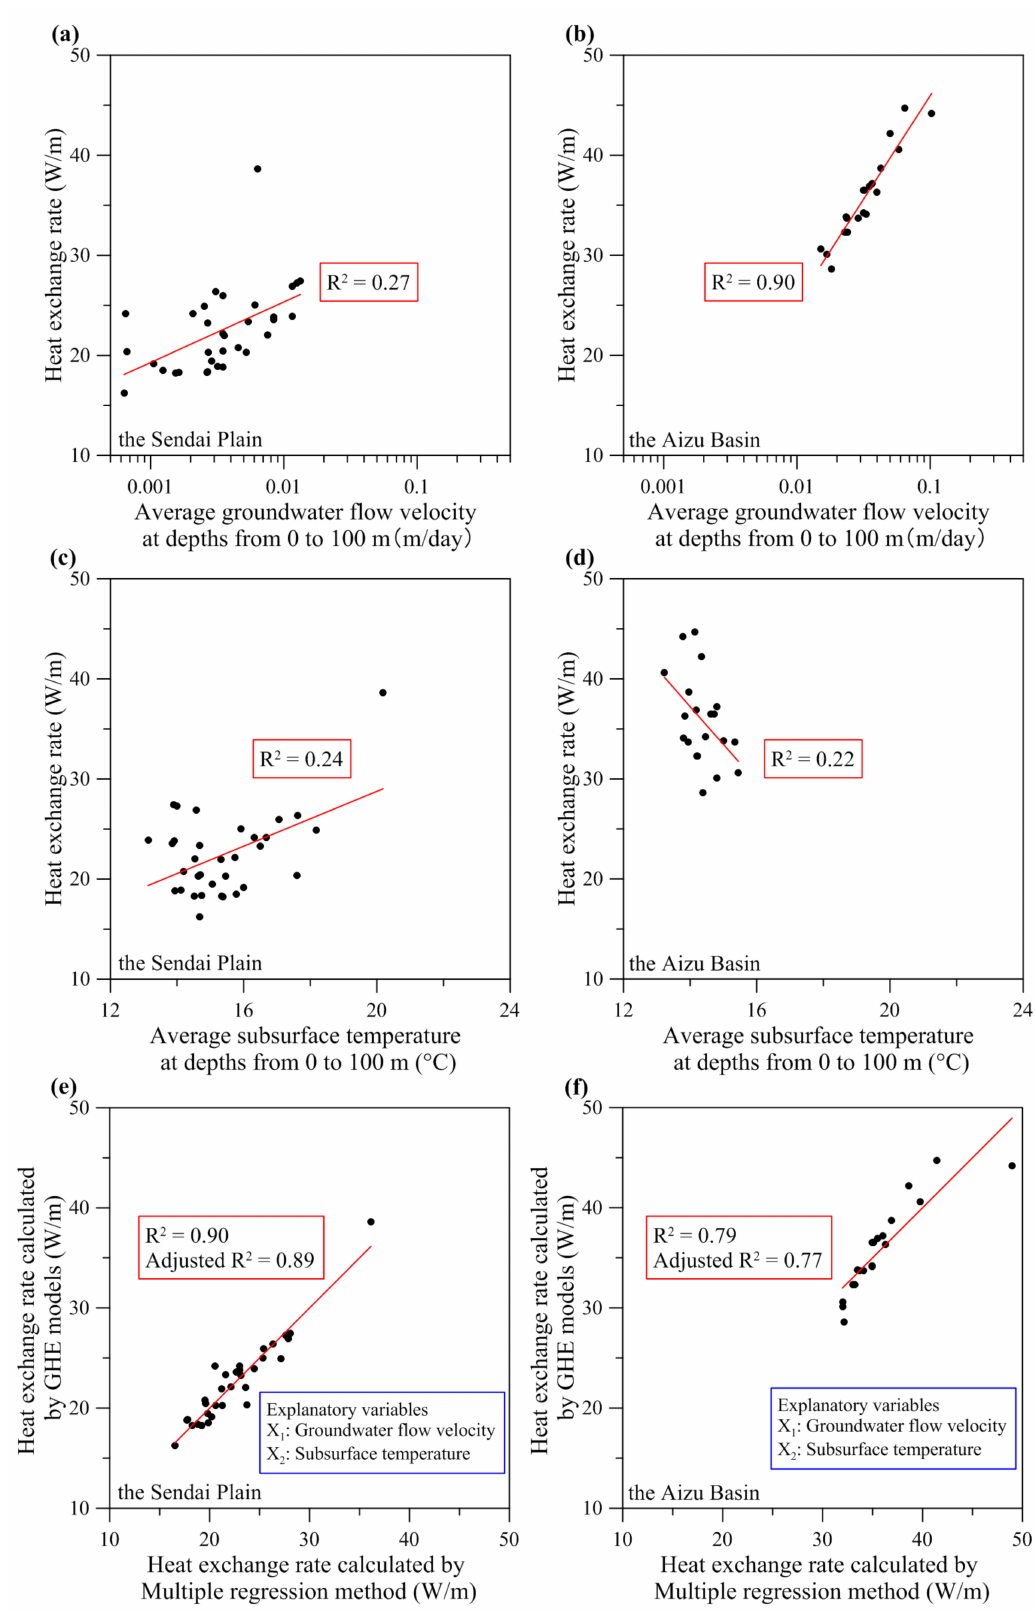
Figure 12. Results of the regression analysis. Relationship between average groundwater flow velocity and heat exchange rate for the ( a ) Sendai Plain and ( b ) Aizu Basin. Relationship between average subsurface temperature and heat exchange rate for the ( c ) Sendai Plain and ( d ) Aizu Basin. Results of the multiple regression analysis for the ( e ) Sendai Plain and ( f ) Aizu Basin. Data for the Aizu Basin were sourced from Shrestha et al.